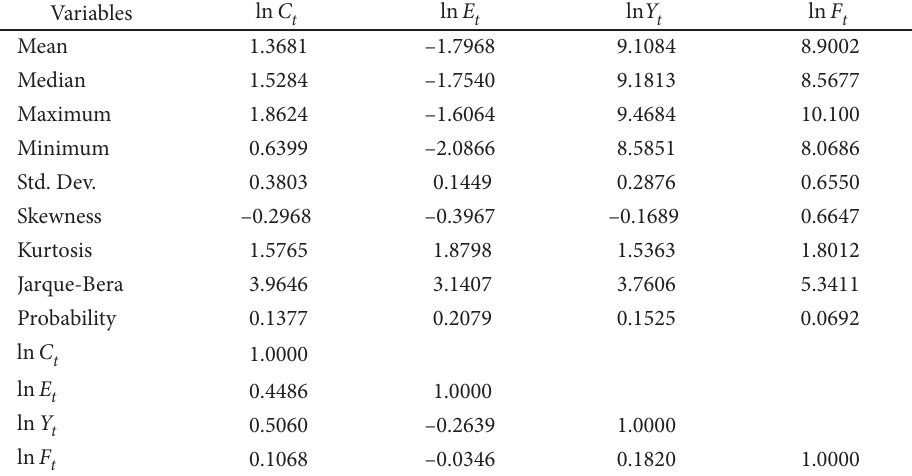
Table 1. Descriptive statistics and correlation